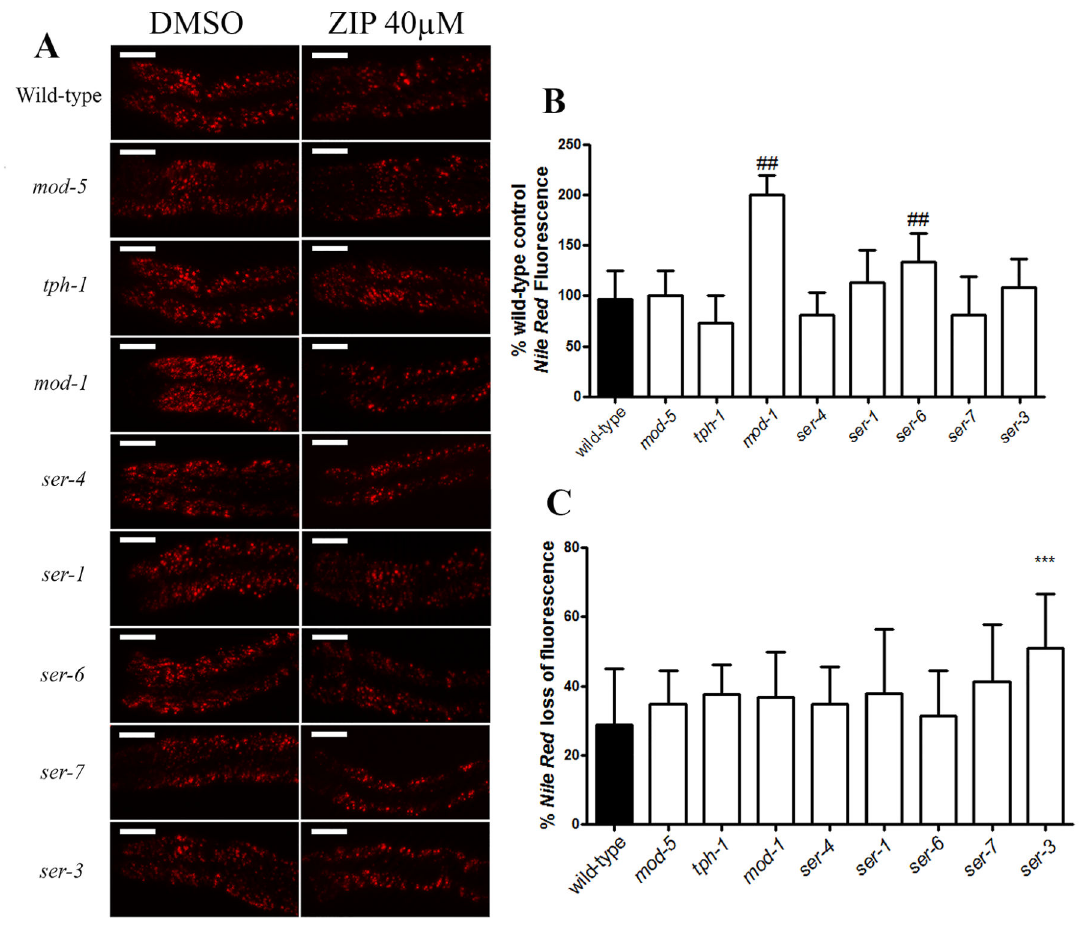
Figure 9. Ziprasidone effect on Nile Red fluorescence of C. elegans mutant to the serotoninergic. (A) Representative images of Nile Red fluorescence on C. elegans wild-type and mutants; (B) Fluorescence profile of Nile Red label on mutants exposed to the vehicle (0.16% DMSO in Acetic acid (1:10 000)) and (C) percentage of loss of Nile Red fluorescence on mutants exposed to Ziprasidone (40µM) compared to the wild-type worm (N2). The treatment began in the L4 larval stage until adult. ##p<0.0001 statistically different compared with wild-type worm exposed to the vehicle; ***p<0.0001 statistically different compared with wild-type worm under Ziprasidone (40µM) treatment (% of control, SD, n> 15, one way ANOVA with Bonferroni correction for post hoc multiple comparisons). doi: